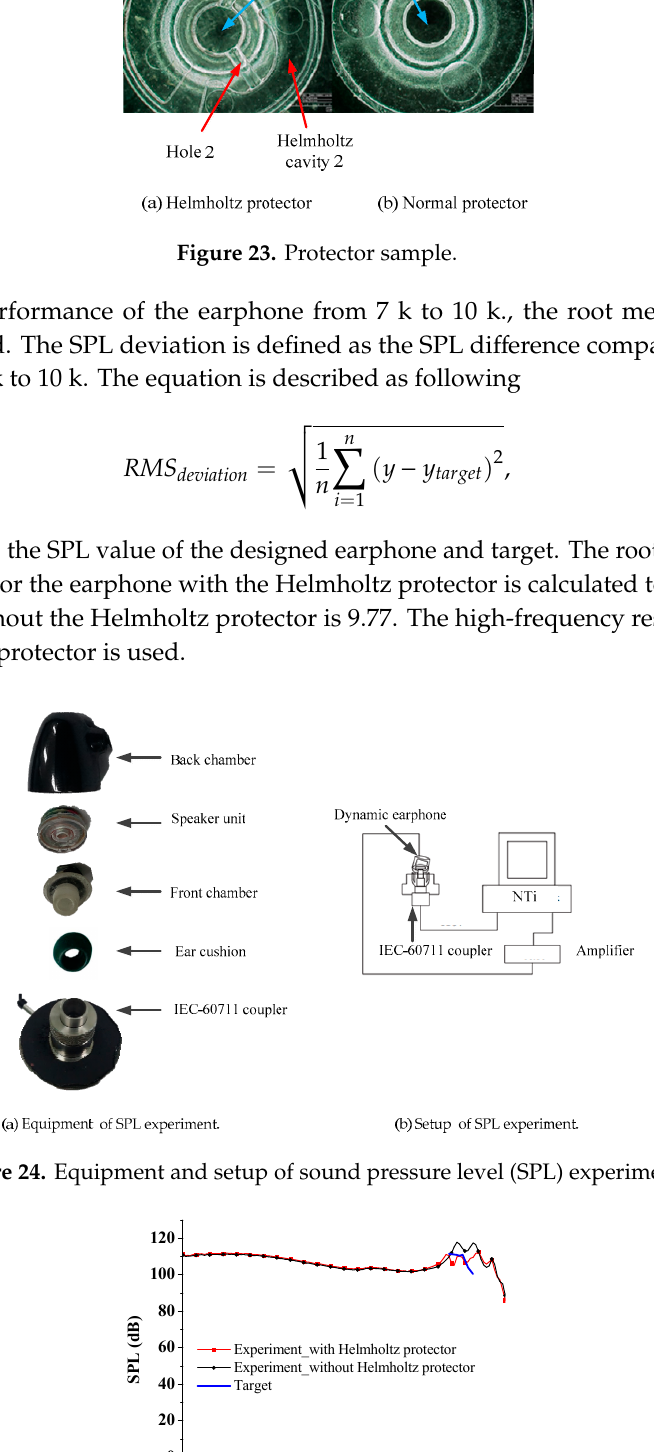
Figure 22. Components of dynamic earphone.